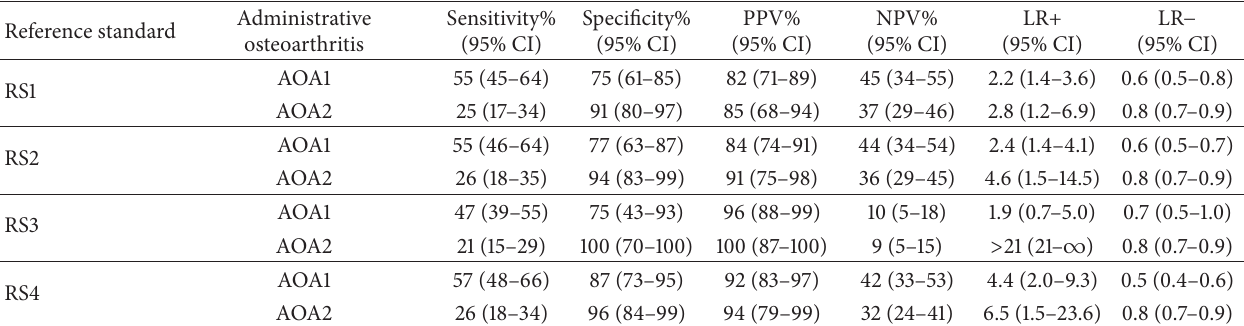
Table 2: Validation results with the 95% confidence intervals of administrative definition of osteoarthritis using four reference standards that include knee, hand, and hip